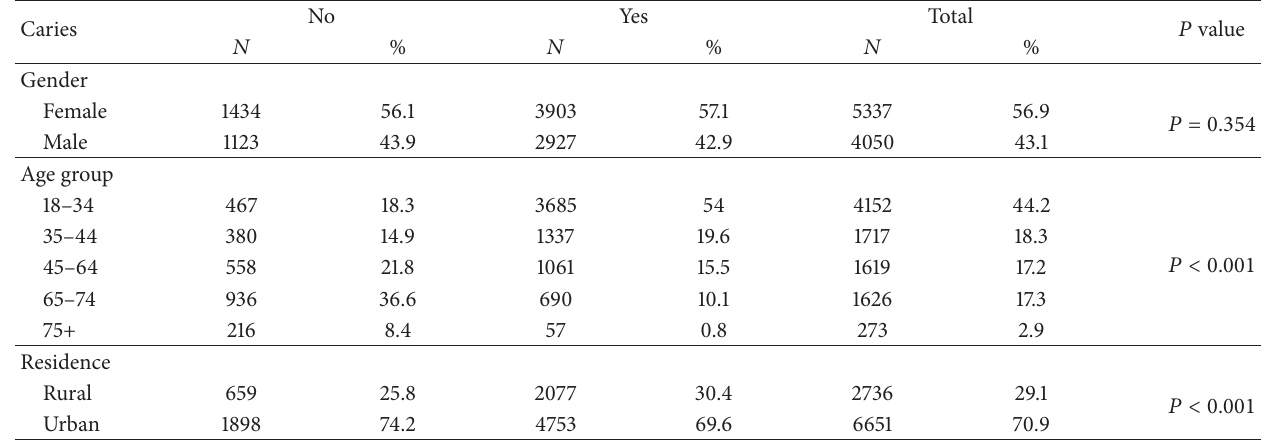
Table 2: Caries presence according to gender, age, and residence.